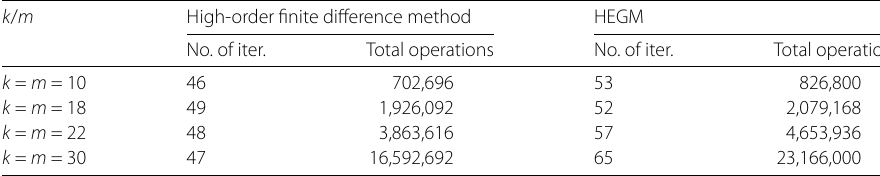
Table 17 The total computation effort for different mesh size for Example 2 when α = 0.5 k / m High-order finite difference method HEGM No. of iter. Total operations No. of iter. Total operations k = m =